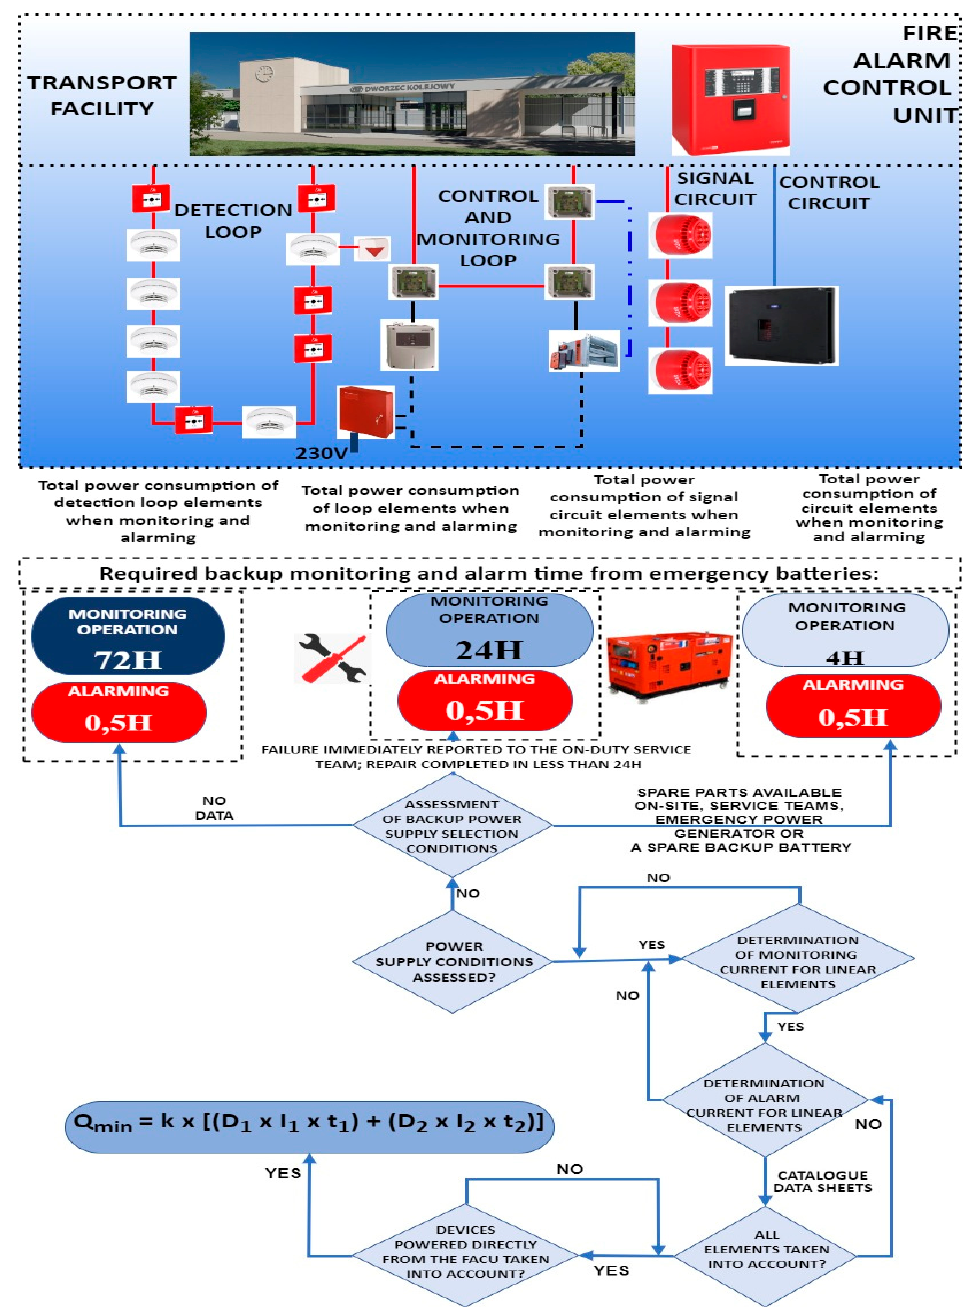
Figure 3. Concentrated FAS energy balance determination graph, where: k-is reserve coefficient, usually taken as 1.25, I 1- determined FAS power consumption in the technical state of monitoring for the first fire system, t 1- required operating time of the FAS in the technical state of monitoring, D 1- coefficient associated with battery capacity upon discharging with the I 1 current (the value should always be obtained from the battery manufacturer; in practice, 1 is adopted for the FAS), I 2- determined FAS power consumption in the technical state of alarm, t 2- required FAS operating time in the technical state of alarm, D 2 -coefficient associated with reduced battery capacity resulting from drawing large-value power under alarm conditions. In the case of typical FACU operating conditions, the adopted value can be 1; however, in the case of AWS, due to the possible broadcasting of a message over all speaker circuits and to all zones, this coefficient may reach a value up to 1.5, H-hour symbol (H = 60 min).